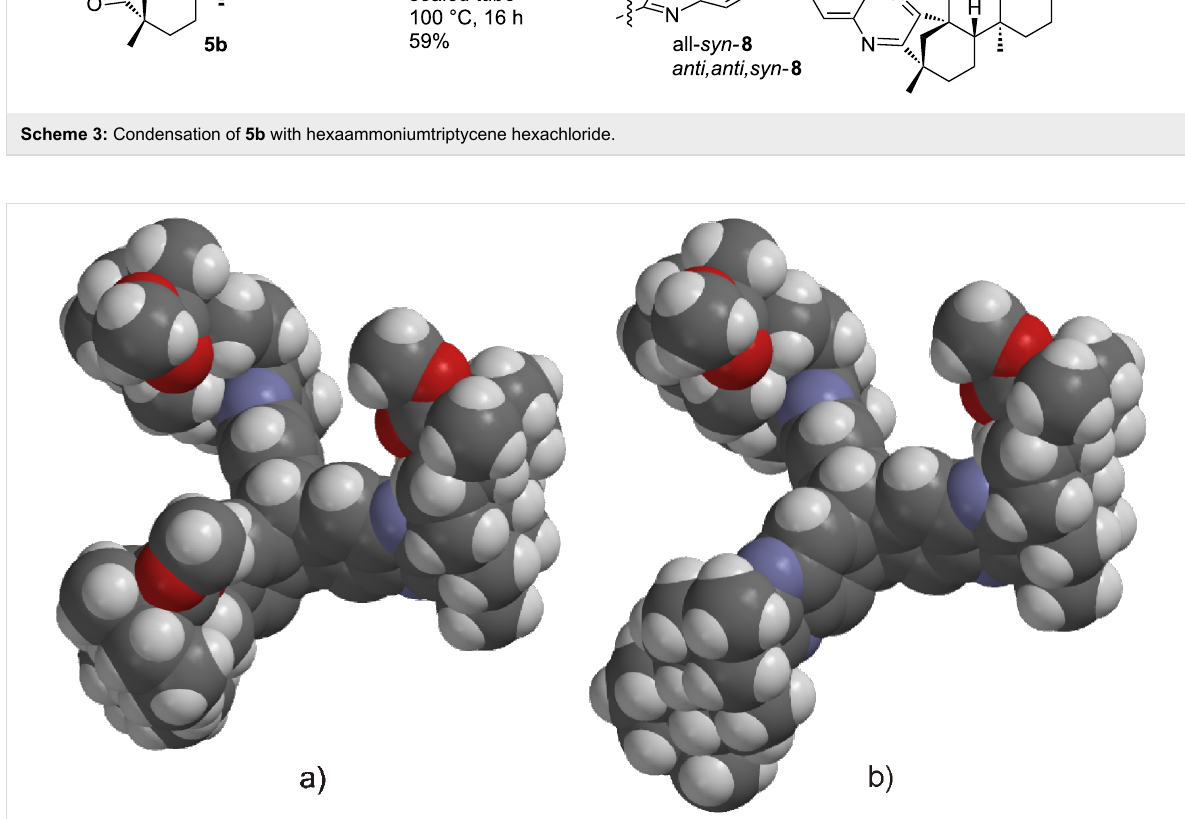
Figure 5: Molecular modelling structures (Spartan ’08 V1.0.0) of (a) all -syn - 8 and (b) anti,anti,syn - 8